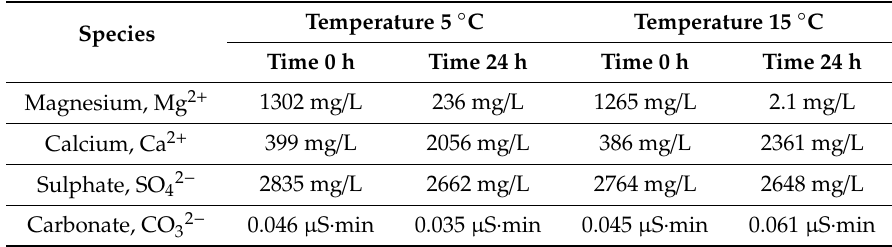
Figure 11. pH in sea water at T = 5 °C (dashed line) and 15 °C (solid line) as function of time after adding 1% ( w / v ) fine CaO. Table 6. Compositional change of sea water at 5 and 15 °C the first 24 h after adding 1% w / v fine CaO.